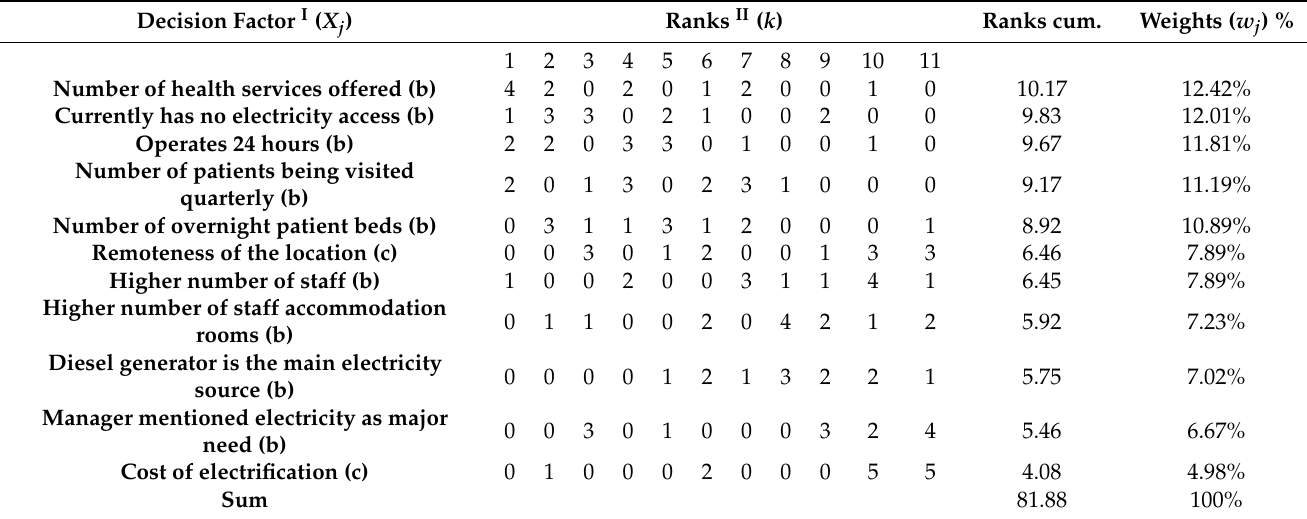
Table 2. Weights calculated for decision factors based on expert opinion